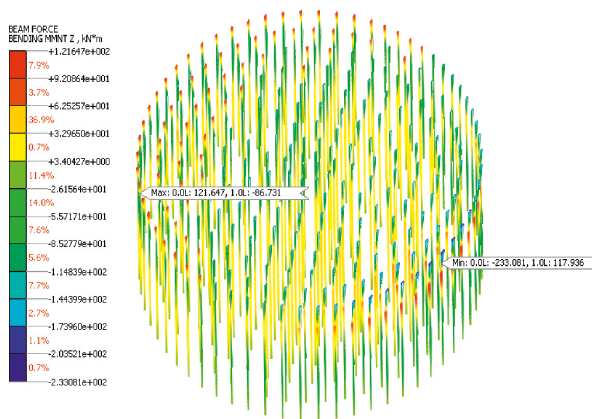
Figure 11: Bending moment distribution diagram of pile group (maximum moment).